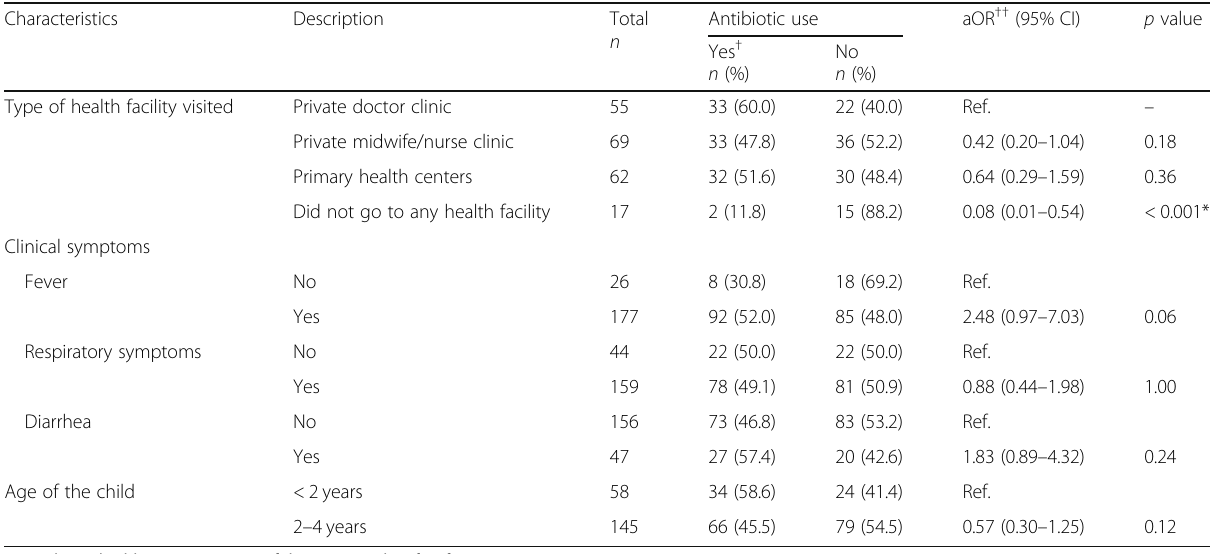
Table 3 Association between antibiotic use and the type of health facility visited, clinical symptoms and age of children ( n = 203) Characteristics